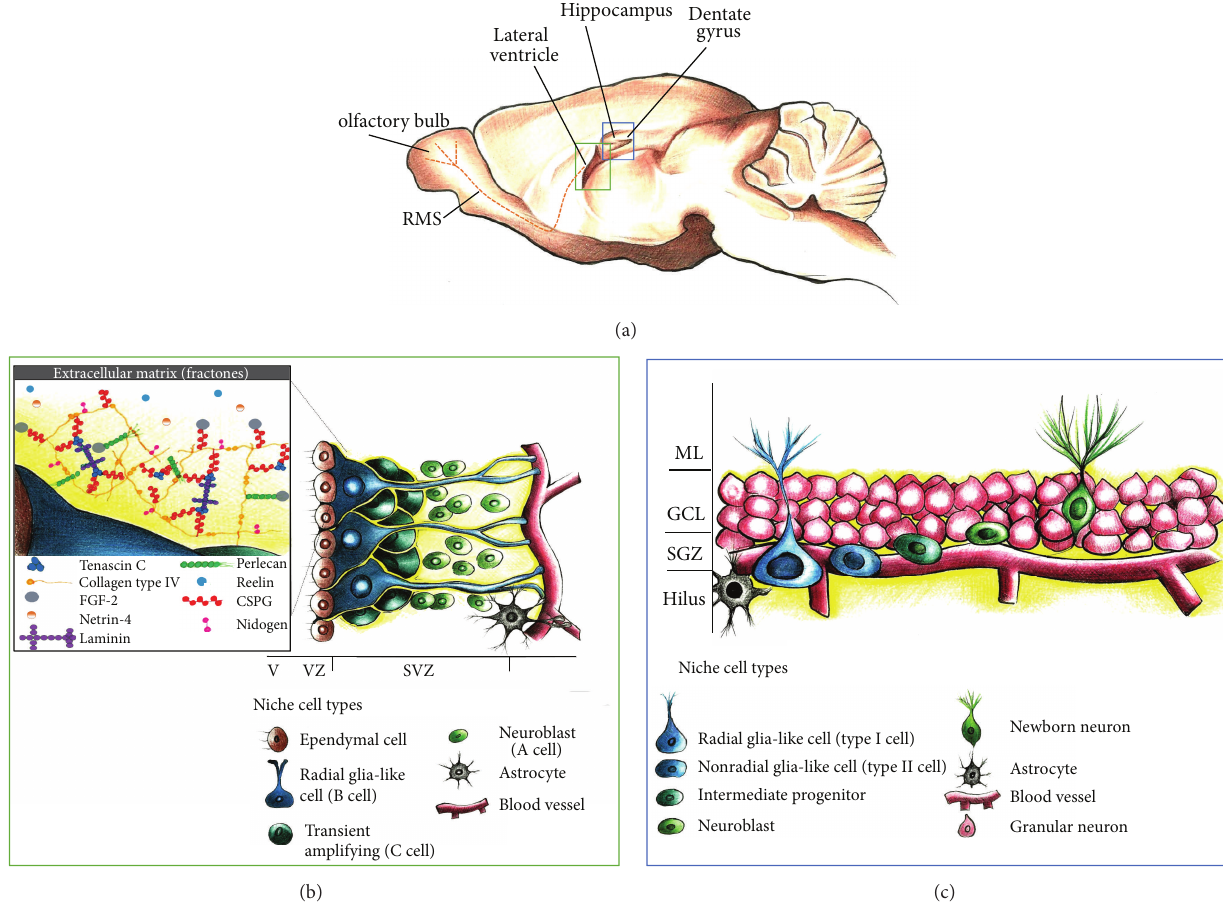
Figure 2: Neural stem cell niche in the adult dentate gyrus and subventricular zone. (a) Sagittal section view of an adult rodent brain showing the two main restricted regions where active adult neurogenesis is present, the dentate gyrus in the hippocampal formation and the lateral ventricle, from which type A cells migrate to form the rostral migratory stream (RMS) toward the olfactory bulb. (b) Neural stem cell niche in the subventricular zone (SVZ). Three types of progenitor cells are found close to the ependymal cell layer in the SVZ: a population of radial glia-like cells (type B cells) have the potential to serve as adult neural stem cells (NSCs) and generate transit-amplifying nonradial NSCs (type C cells), which later give rise to neuroblasts (type A cells). The SVZ includes several ECM components (yellow), called fractones (inset), which make contact with all the cell types, including the blood vessels and astrocytes in this region. (c) In the adult subgranular zone (SGZ), a population of radial glia-like cells (type 1 cells), along with nonradial glia-like cells (type 2 cells), generate neuroblasts. These neuroblasts then migrate into the granule cell layer and mature into neurons. CSPG, chondroitin sulfate proteoglycan; FGF2, fibroblast growth factor 2; GCL, granular cell layer; ML, molecular